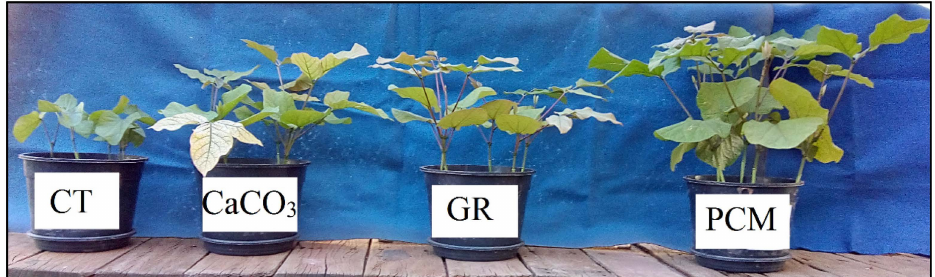
Figure 2. Jack bean plants in the CT, CaCO 3 , GR and PCM treatments at harvest day. CT = Control, GR = Coffee grounds biochar, and PCM = Coffee parchment